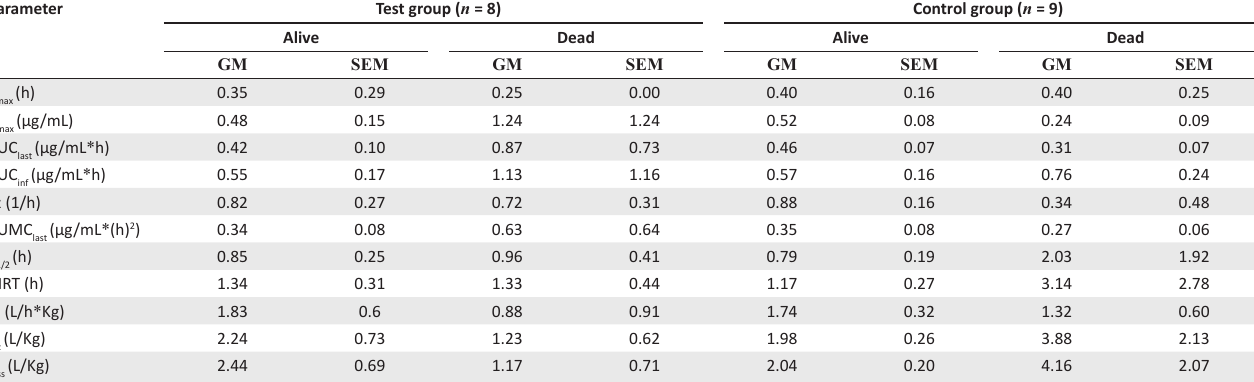
TABLE 1: Pharmacokinetic parameters for diclofenac in test and control birds following intravenous diclofenac exposure. Presented as geometric means (GM) on dose- corrected parameters, with the standard error of the mean (SEM). Parameter Test group ( n = 8)